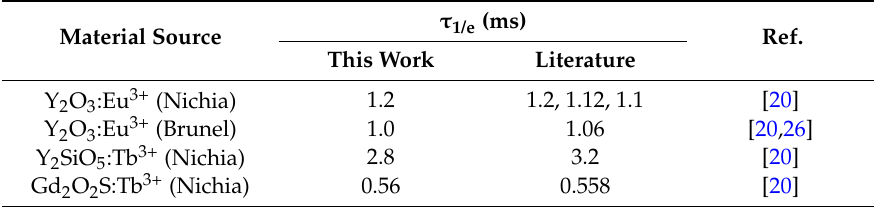
Table 1. Decay times determined from CL ‐ images in Figures 7 and 8.